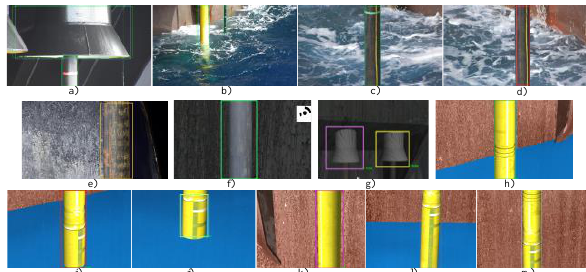
Figure 10. Detection results of risers and i-tubes from real and virtual images.